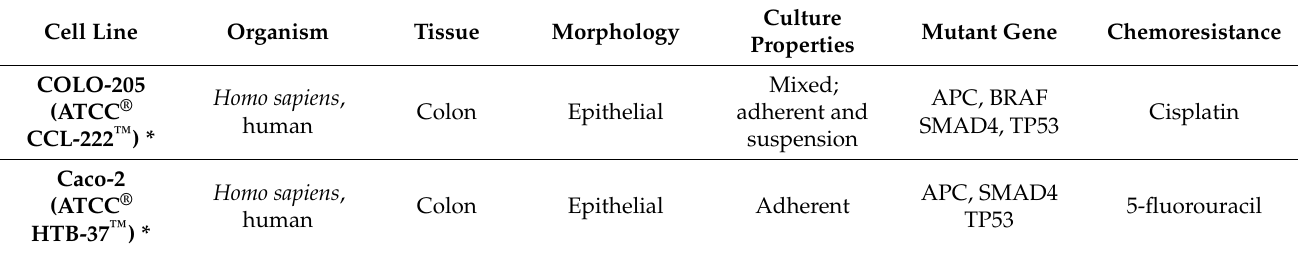
Table 2. Type of cells used in the